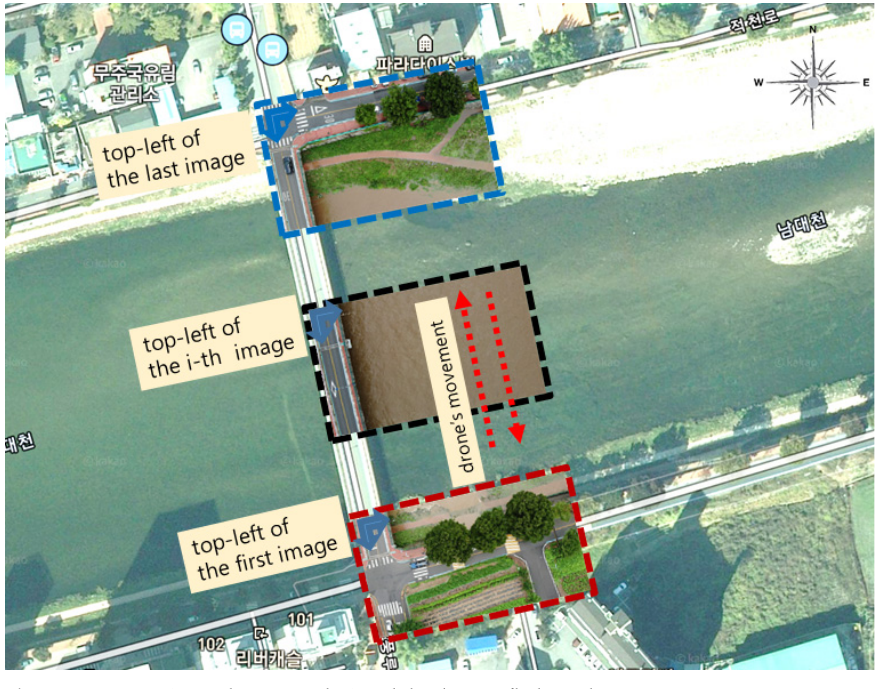
Figure 8. Test site (Mujudaegyo Bridge) and the drone’s flight path. The video was filmed from an altitude of 50 m over the 30 m upstream area of the Mujudaegyo Bridge, from the left bank to the right bank, and then from the right bank to the left bank, at a flight speed of 2.0 m/s. However, since the first and last segments are difficult to use due to the changed course, 2048 frames in the middle (frame 1252 matching the left bank, frame 3300 reaching the right bank) were used for the northward flight im ‐ age, which was acquired for 68 s. Similarly, 2048 frames (from frame 3522 on the right bank to frame 5543 on the left bank) were used for the south direction flight image. As a result of examining the video in Figure 5 using the method presented in Figure 2, the moving direction of the drone was θ = 105.1°, and the video direction was φ = − 15.1°. In this case, 11 grid points at 2.0 m intervals in the horizontal direction and 29 grid points at 5.0 m intervals in the vertical direction were used as the grid.